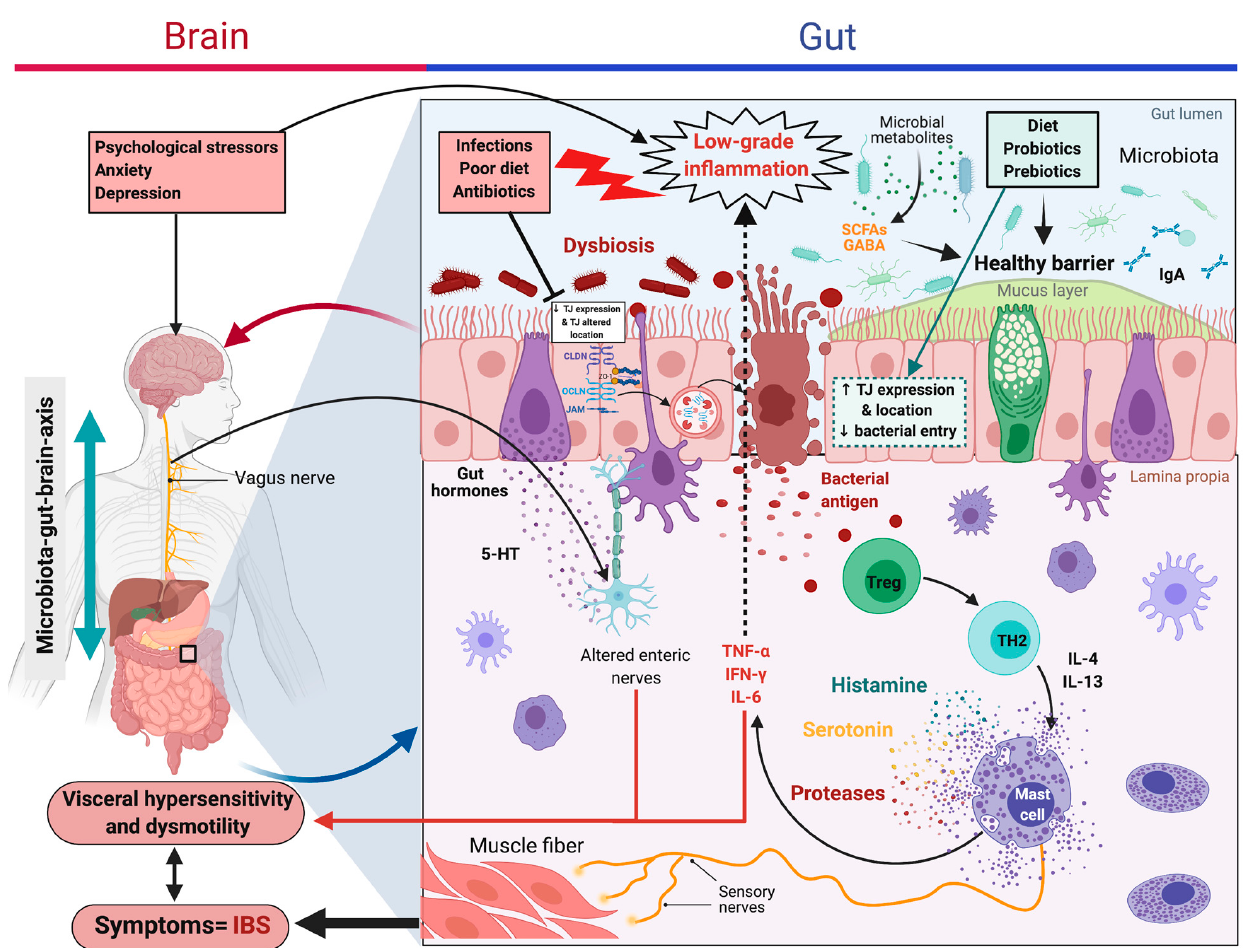
Figure 3. Increased intestinal permeability in irritable bowel syndrome (IBS). Main interactions described in IBS: different stimuli (e.g., bacterial or food antigens) can increase intestinal permeability through degradation or internalization of certain binding proteins that trigger MCs activation. These cells secrete pro-inflammatory cytokines that aggravate the altered permeability. In addition, histamine, serotonin, and proteases released by degranulated MCs are responsible for nerve excitation and the subsequent abdominal discomfort, pain, and intestinal transit changes. Microbiota of IBS patients shows lower biodiversity or an altered composition of microbes; thus, the use of probiotic strains, prebiotics, or synbiotic combinations has become a potential therapy to improve the composition of the intestinal microbiota. Their anti-inflammatory activities are also beneficial to IBS patients. (This figure was created with Biorender.com, access date: 24 May 2021).